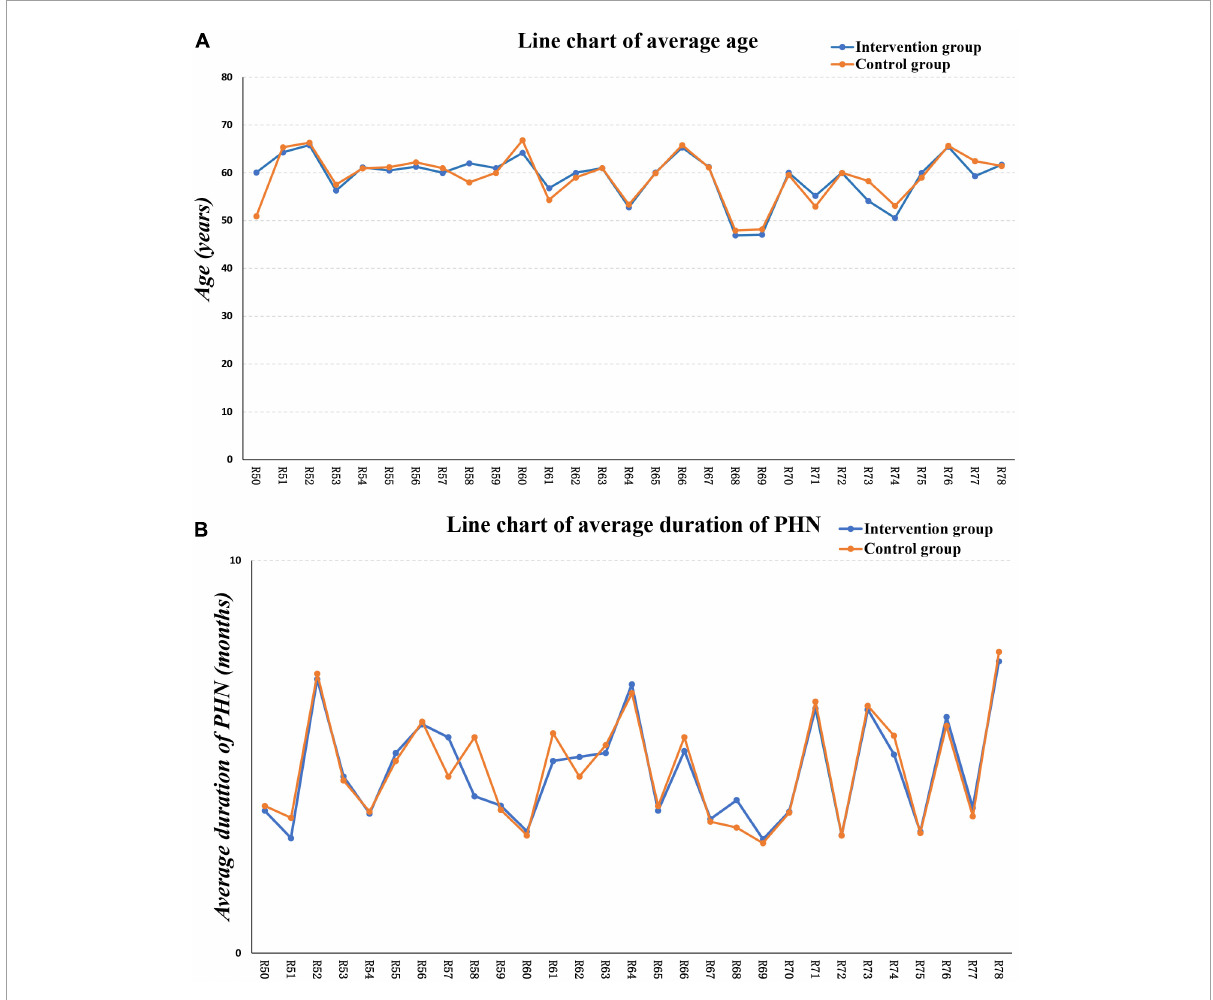
FIGURE2 Baseline assessment. (A) The average age assessment, (B) the average PHN duration